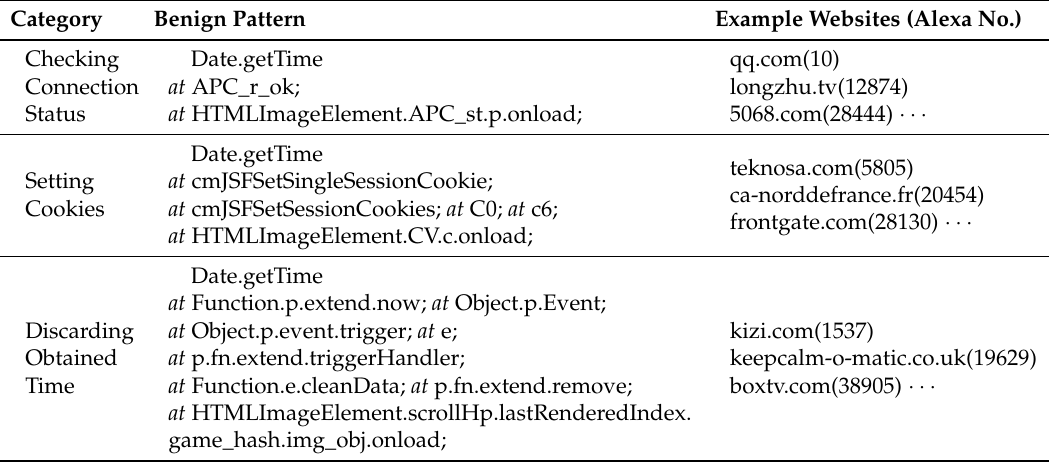
Table 1. white-listed behavior patterns of web caching-based timing probing attack.